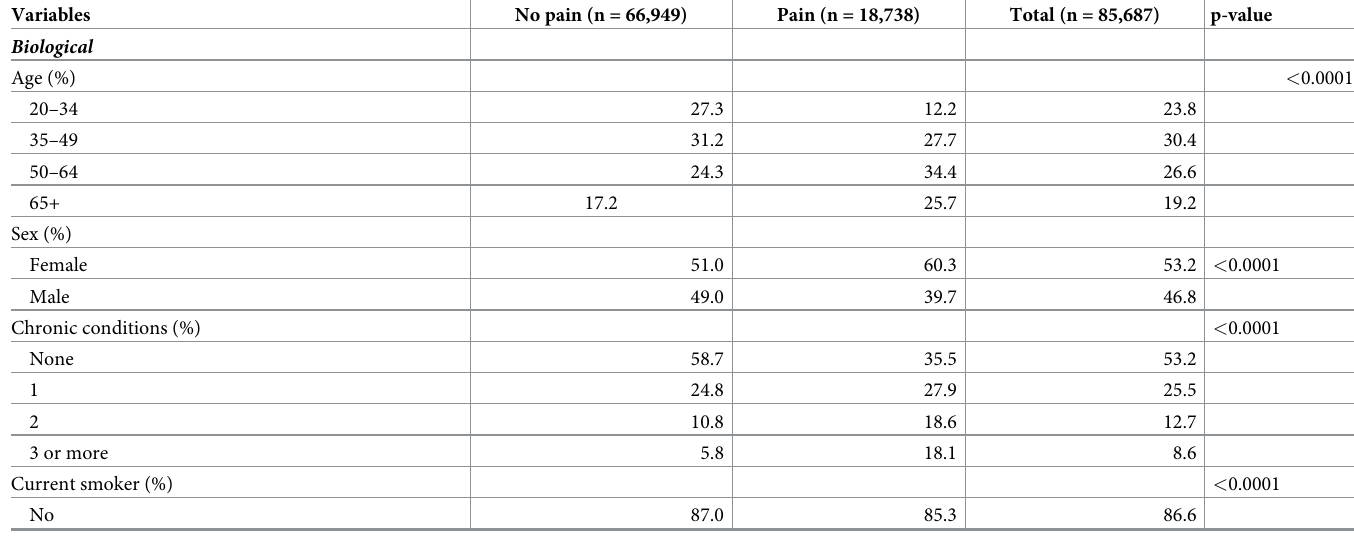
Table 1. Descriptive statistics of the sample according to back pain